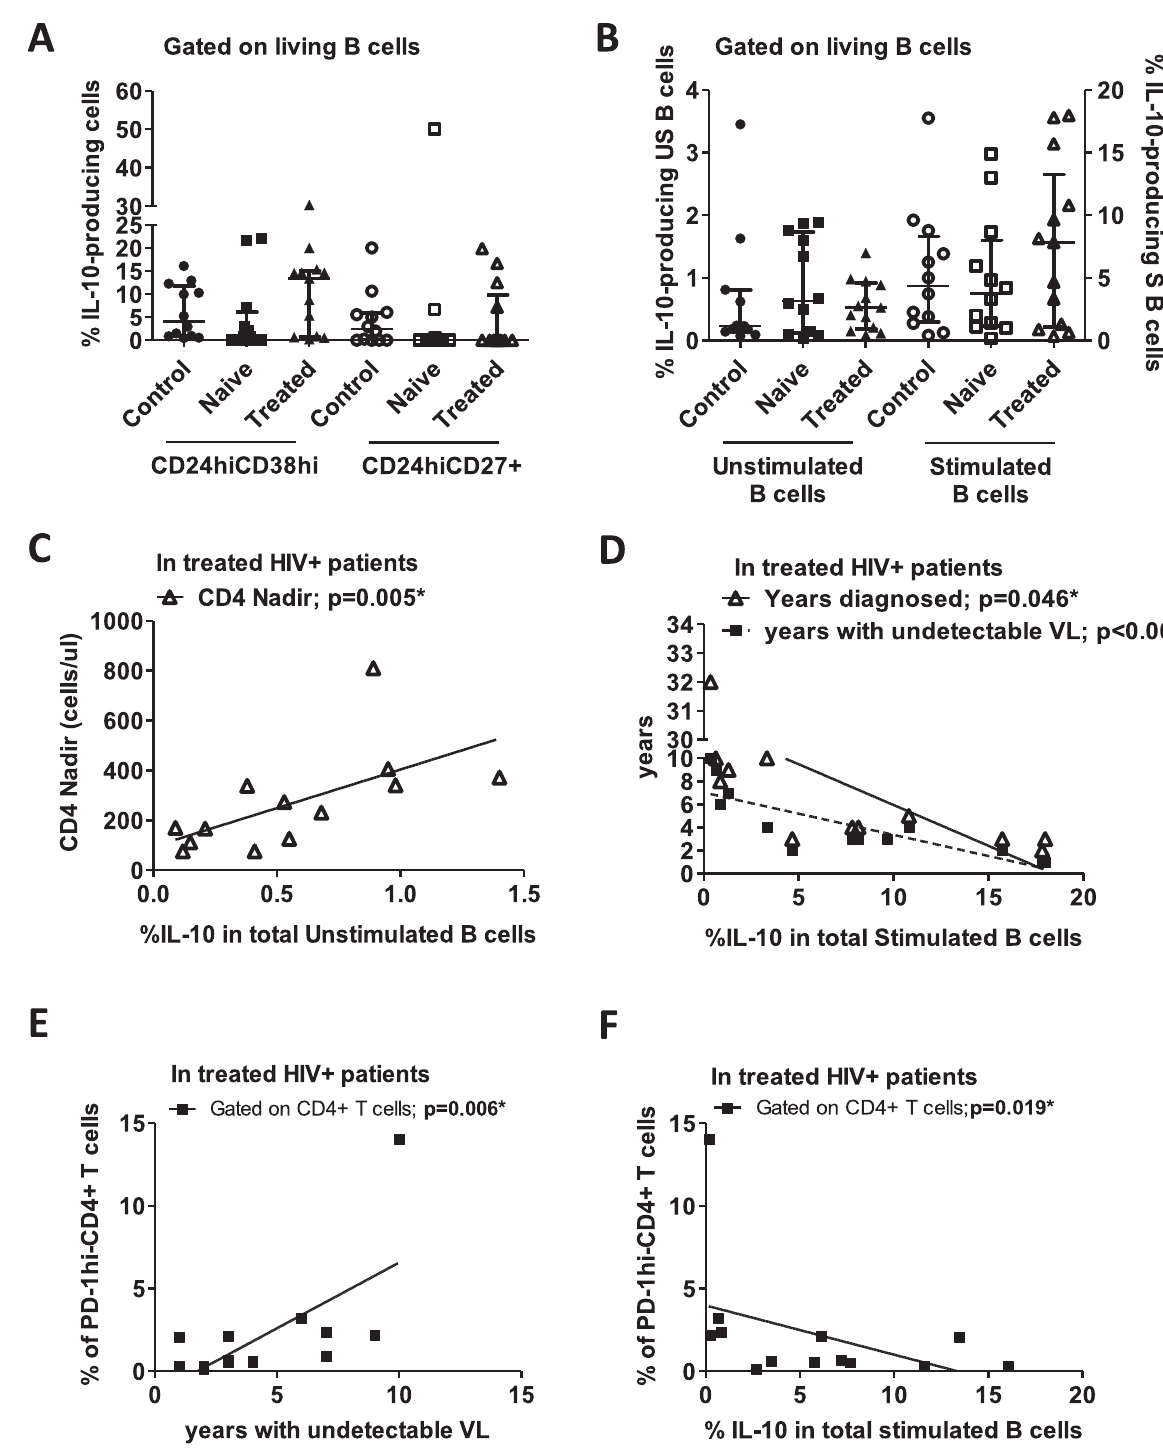
Fig 3. IL-10-producing Breg subsets in HIV + patients and healthy individuals. PBMCs were isolated, and some cells were stimulated with CD40L/LPS/CpG. After 2 days, cells were labeled for surface markers and intracellular IL-10. (A) Frequencies of IL-10-producing- CD19 + CD24 hi CD38 hi and CD19 + CD24 hi CD27 + ; (B) Frequencies of unstimulated (US) and stimulated (S) total IL-10-producing B cells. Frequencies were obtained with gating on CD19 + cells. (C) Correlation between basal expressions of IL-10 (frequency of IL-10-producing B cells without stimulation) and CD4 nadir count in treated-HIV + individuals. (D) Correlation between frequencies of IL-10-producing B cells and years diagnosed or years with undetectable VL in treated-HIV + individuals. (E) Correlation between frequencies of PD-1 hi -CD4 + T cells and years with